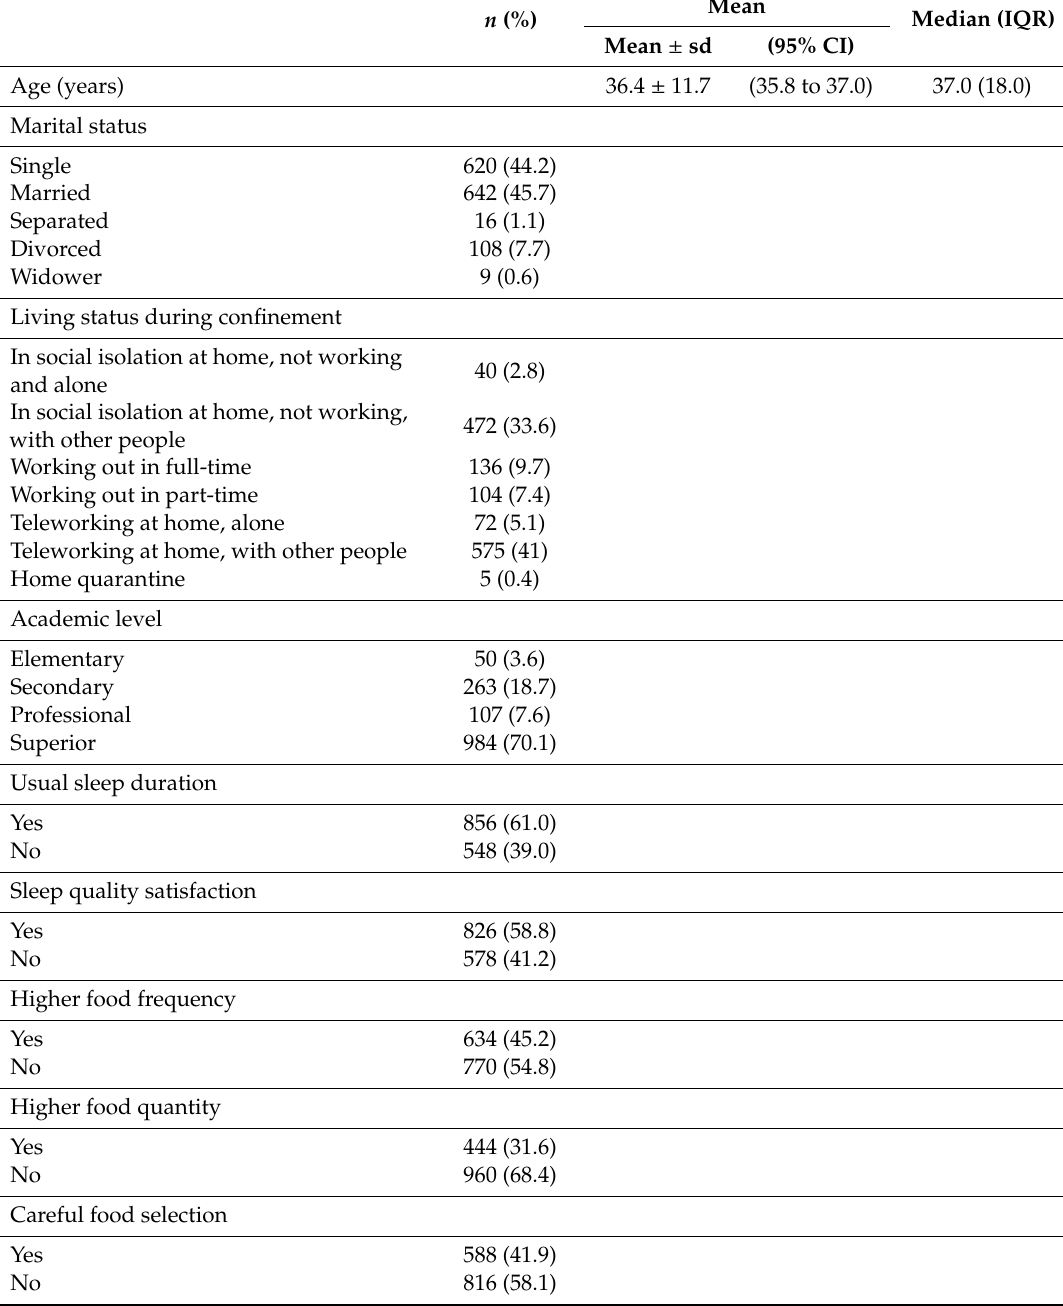
Table 1. Summary of the descriptive statistics for the sample characteristics ( n =